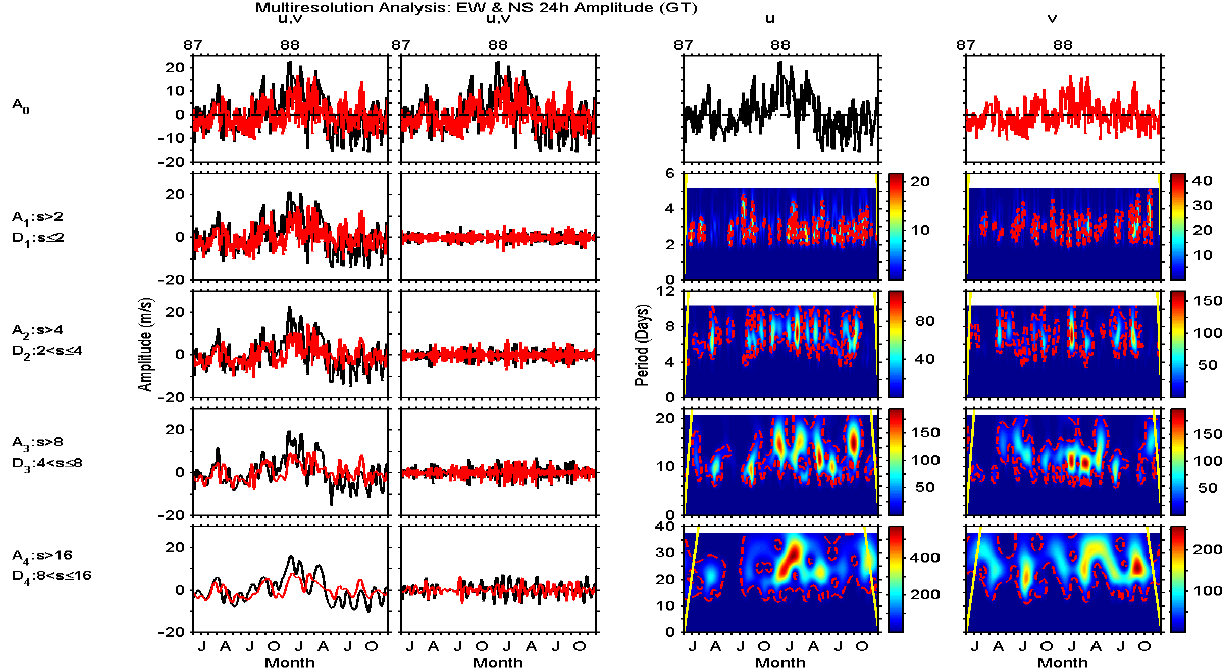
Fig. 3. Analysis of the diurnal tide at Grahamstown: Top row, the original signal A o . Rows 2–5, starting from the left, show (1st column) the approximations ( A m where m is the level), (2nd column) the details ( D m ), (3rd column) the spectrum of the zonal details and (4th column) the spectrum of the meridional details. The black and red time series lines represent the zonal ( u ) and meridional ( v ) amplitudes, respectively. The scale ( s ) ranges are shown on the left. The units of the colour bars are arbitrary.